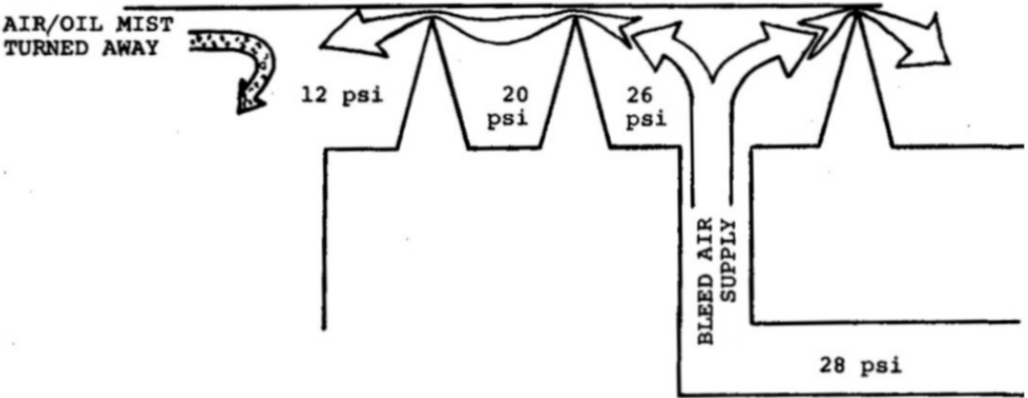
Figure 7. Flow through the labyrinth seal in the TPE331 engine next to the compressor bearing and resulting pressure. The flow to the left pushes back the oil that still comes through the carbon seal (based on Figure 13 in